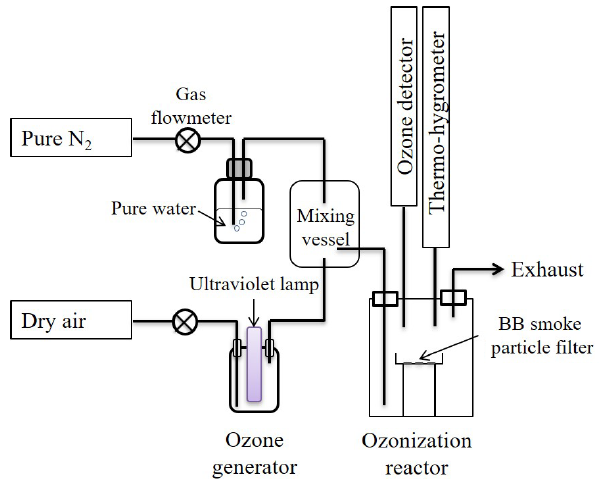
Figure 1. The experimental